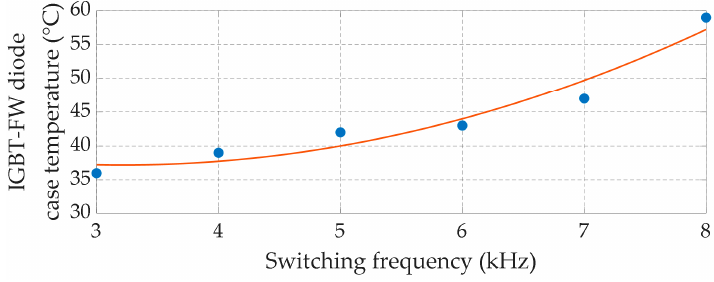
Figure 9. Measured temperature of the IGBT-FWD case at different switching frequencies.